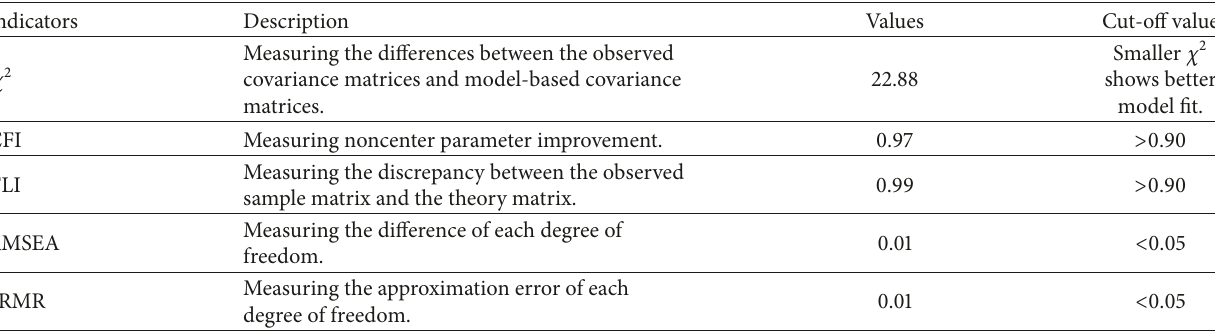
Table 3: Goodness-of-fit of model.